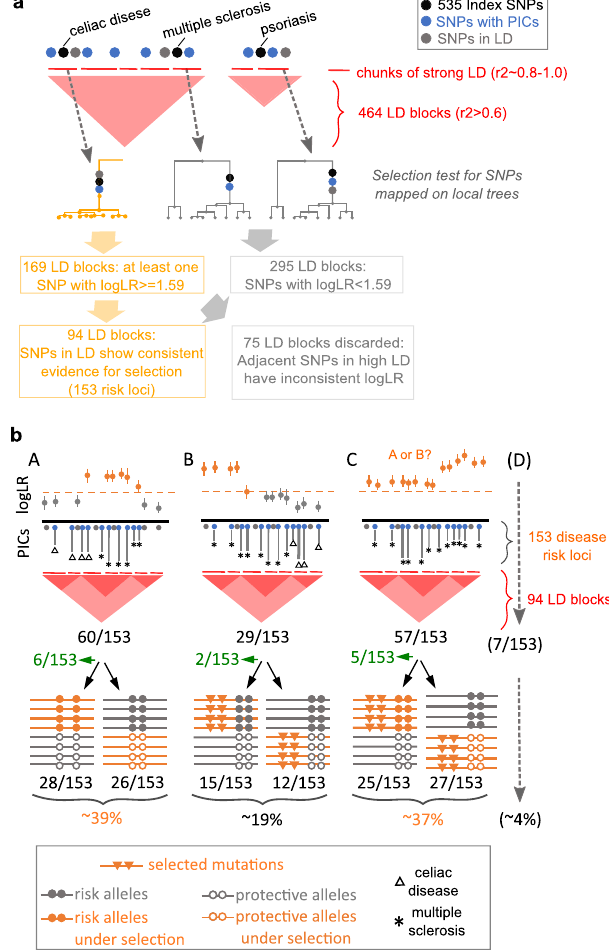
Fig. 2 | Evolutionary scenarios for candidate causal SNPs based on logLR fi ne- mapping. a Spatial organization of disease risk loci and selection test work fl ow. Single disease risk loci (asthma and psoriasis) and multiple disease risk loci within LD blocks (triangular heatmap) are shown schematically. Selection tests are performed foreachsmallchunk(redsegmentsabovetriangularheatmap)withindiseaseriskloci. Nearby chunks, depending on local LD, have correlated local trees and evidence for selection.Weusedthisfacttoadditionally fi lteroutspuriousselectionsignalsthatare notconsistentwithnearbychunks.Forexample,asinglechunkwithlogLR=2.5stands out from adjacent chunks with logLR=0.5. b Evolutionary scenarios based on com- paring SNPs with top logLR and PICS. The top row schematically shows three evolu- tionary scenarios (A, B, C) discernible for the 153 disease risk loci with a consistent signalof selection: (A)top candidate causal variant(s) (with the highest PICS value)is/ are likely sweep-driving mutation(s) (SNP(s) with the highest logLR value); (B) top candidate causal variant(s) is/are hitchhiking; (C) complex scenario: top candidate causal variant is either sweep-driving mutation itself or hitchhiking with a stronger target of selection. Black arrows further classify evolutionary scenarios at the haplo- type level (shown schematically on the bottom row) by clarifying whether selection and hitchhiking affected the risk or protective allele. Arrows and numbers in green summarize cases where allele information is missing. We, therefore, distinguish six sub-categories at the haplotype level that are depicted on the bottom row. Full annotation graphs for the 153 risk loci classi fi ed in this fi gure are available in the Figshare repository (See Data availability statement). Raw data for this fi gure are provided in Supplementary Data